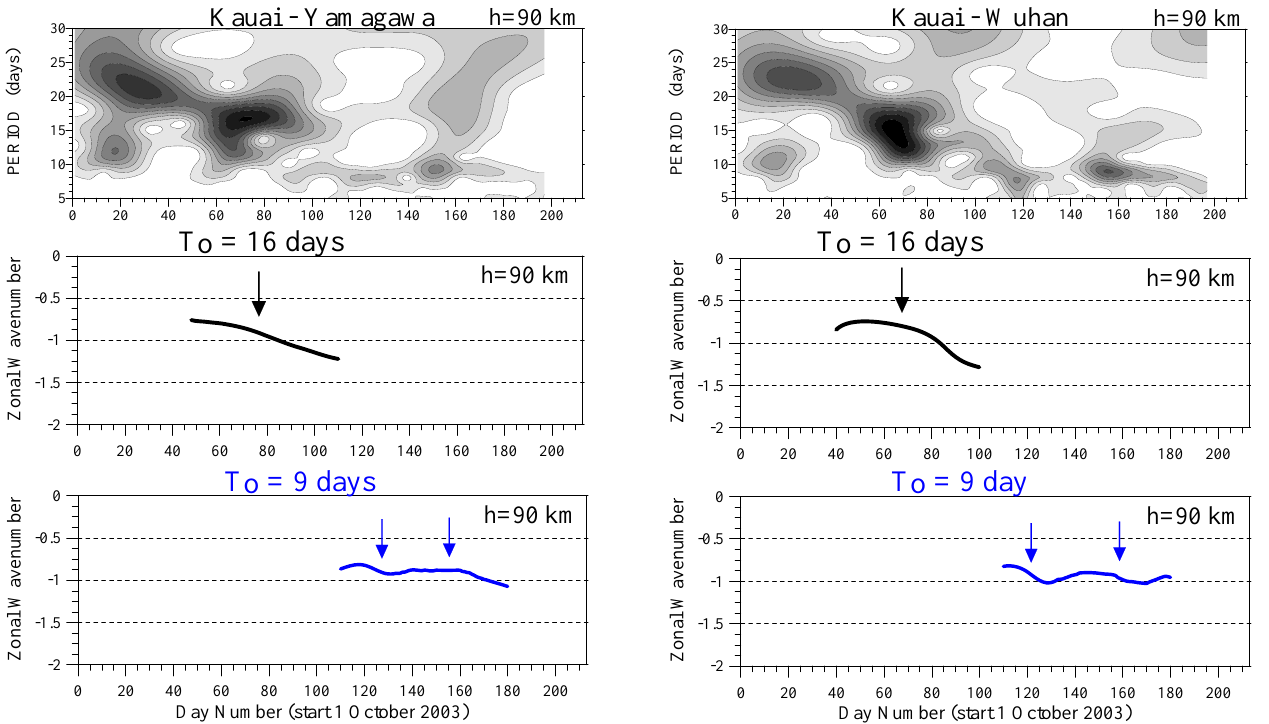
Figure 13 Fig. 13. Cross wavelet power spectra calculated for the couple of stations: Kauai-Yamagawa and Kauai-Wuhan (upper row of plots). The middle and bottom row of plots show the zonal wavenumbers of the 16- and 11-day waves, respectively, calculated from the wavelet phase difference between both couple of